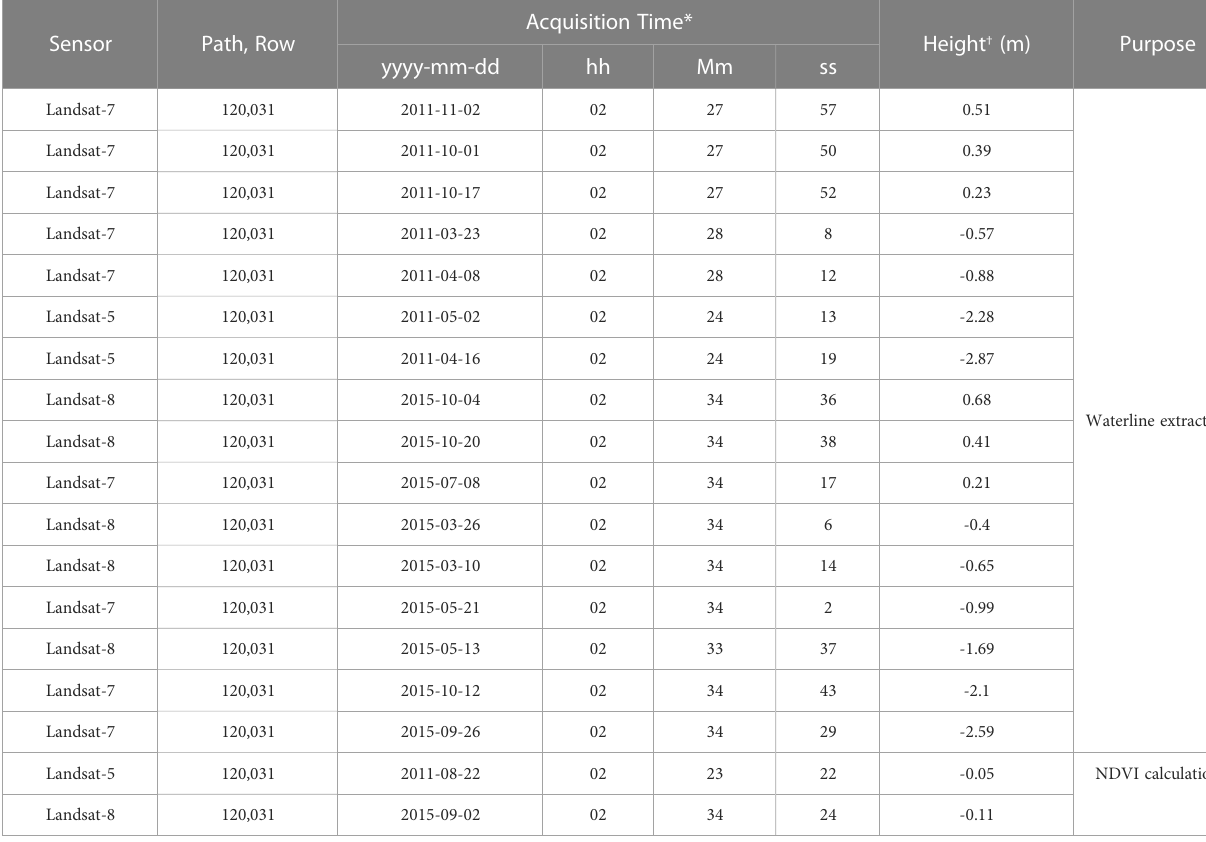
TABLE 1 Remote sensing images used for waterline extraction and NDVI calculation.